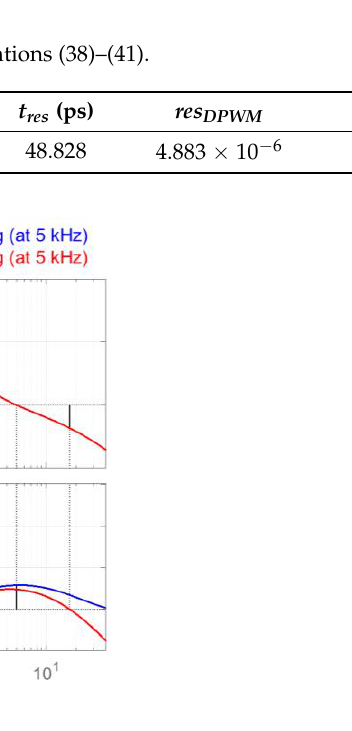
Figure 21. Bode plots of the compensated loop gain T c ( s ) including the sampling delay effect.